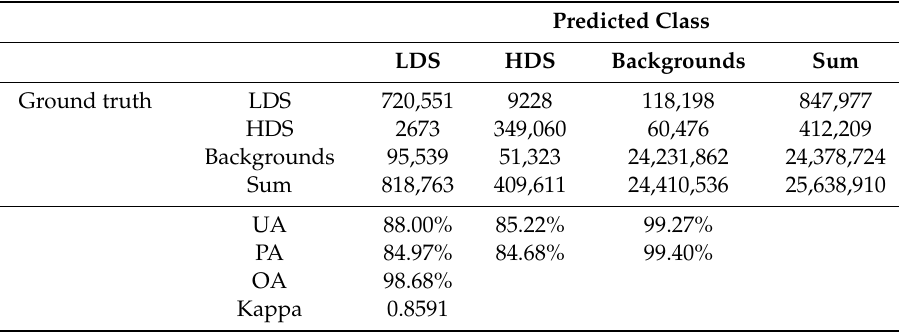
Table 3. Confusion matrix of polygon test set (m 2 ).